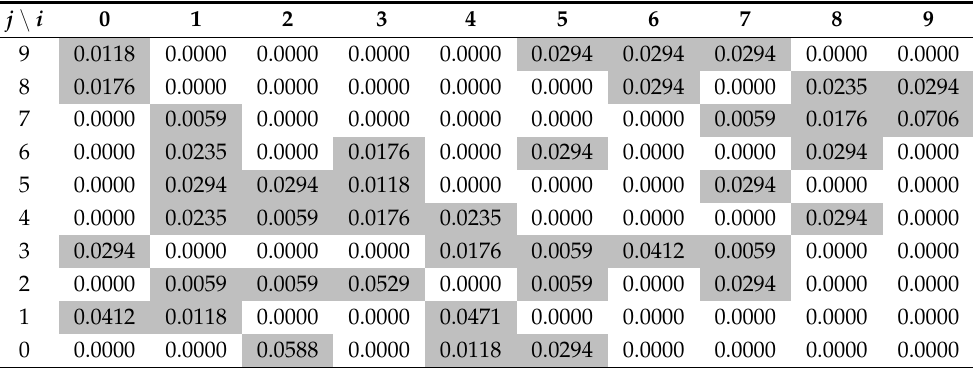
after application of the adaptive strategy in Example Table 9. Probabilities p ˚ ij